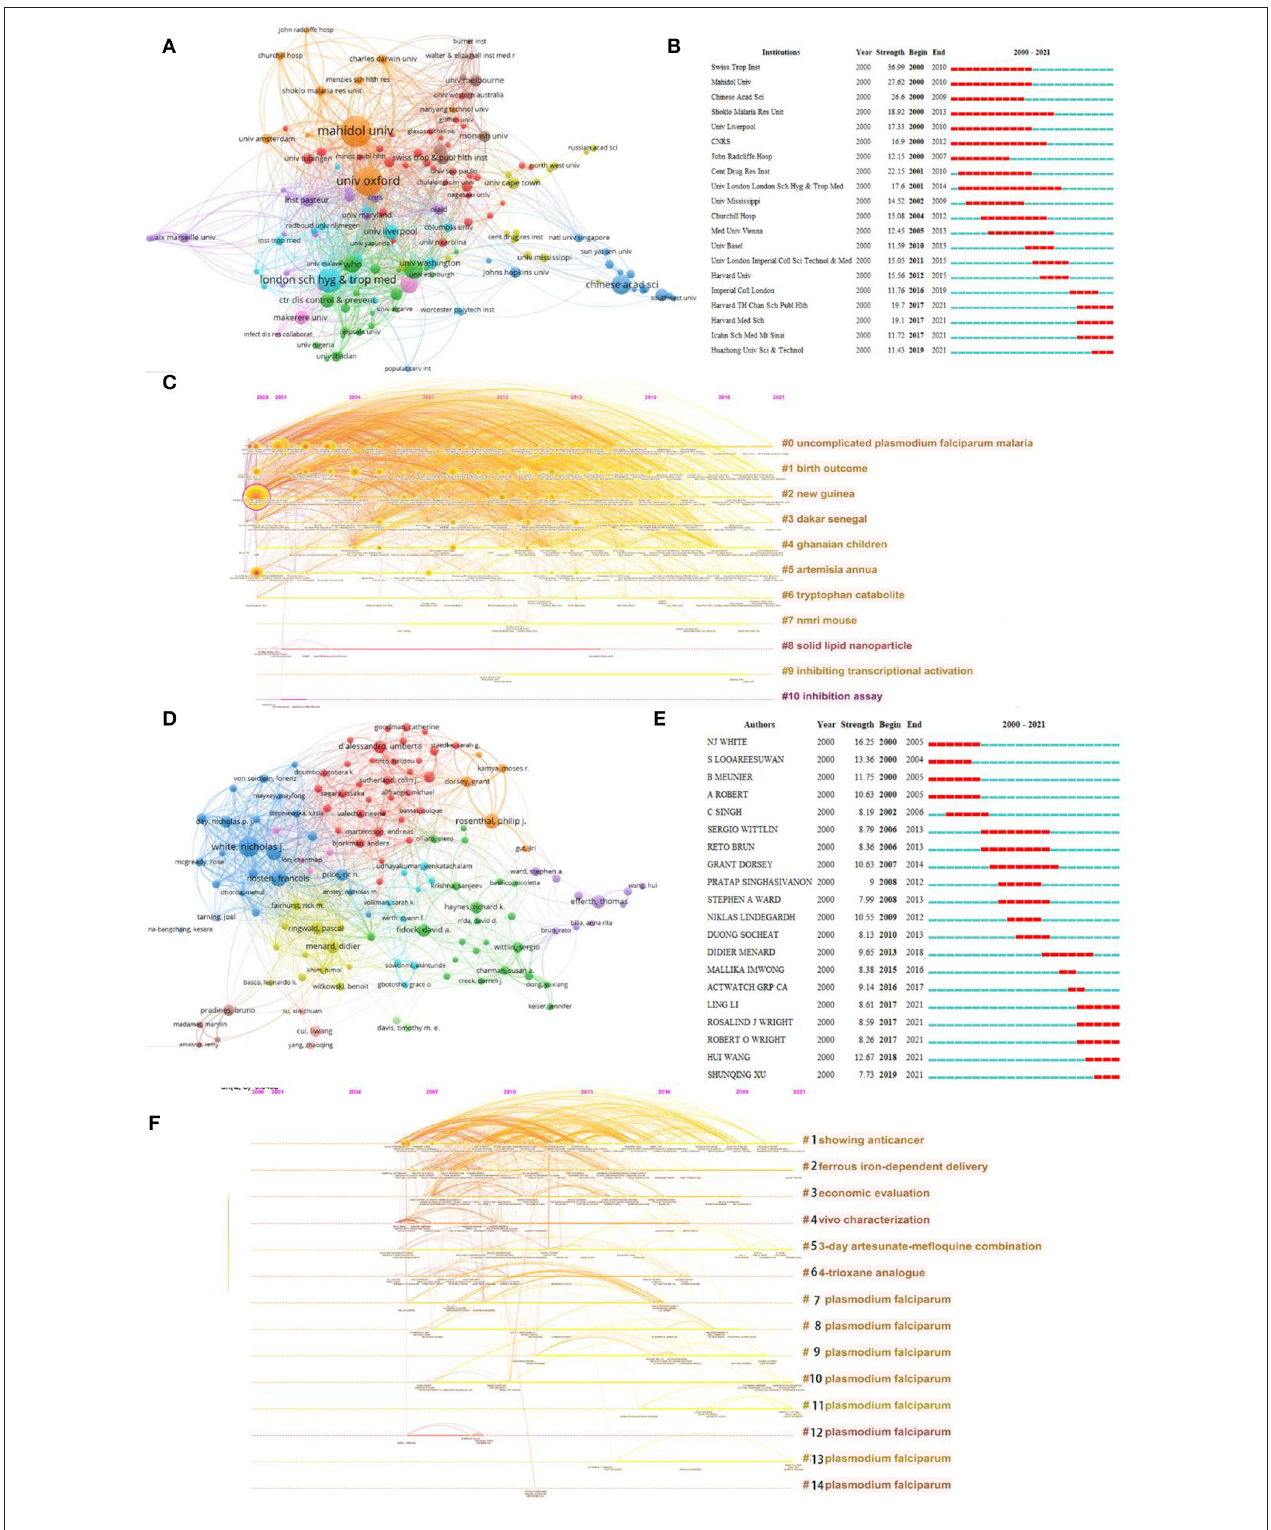
FIGURE 4 | Visualization of active affiliations and author analysis. (A) Analysis of cooperation among affiliations. (B) Top 20 representative burst affiliations. (C) Timeline distribution of cluster analysis of affiliation. (D) Analysis of cooperation among authors. (E) Top 20 representative burst authors. (F) Timeline distribution of cluster analysis of the